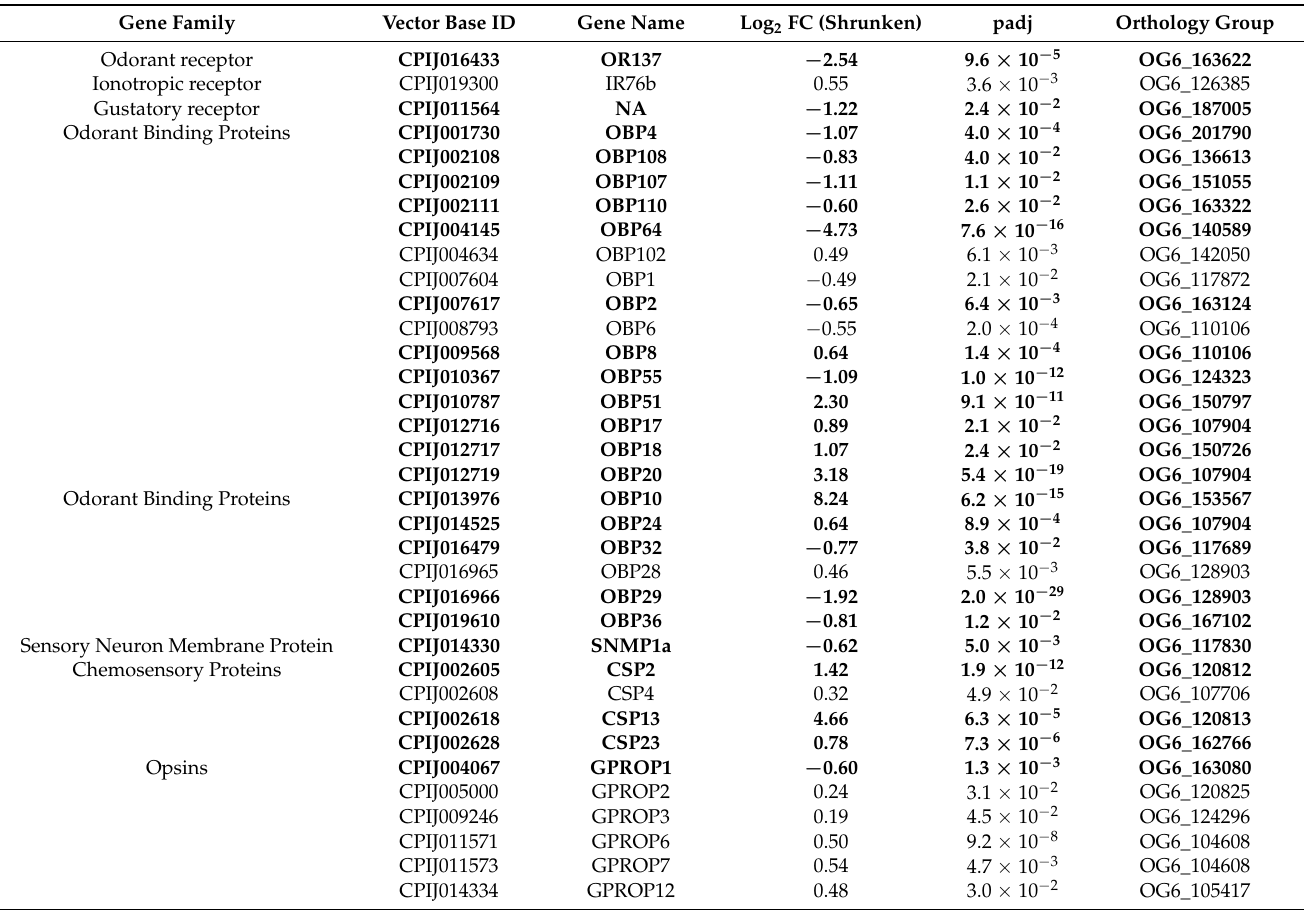
Table 3. Differentially expressed genes with sensory function in the whole heads of above-ground (AG2) host-seeking females relative to below-ground host-seeking females. p -values are adjusted for multiple comparisons using a Benjamini- Hochberg false discovery rate correction. Bolded lines have both a statistically significant Benjamini-Hochberg adjusted p -value (padj) and an absolute log 2 fold change (FC) value greater than 0.58 (equivalent to a 1.5-fold